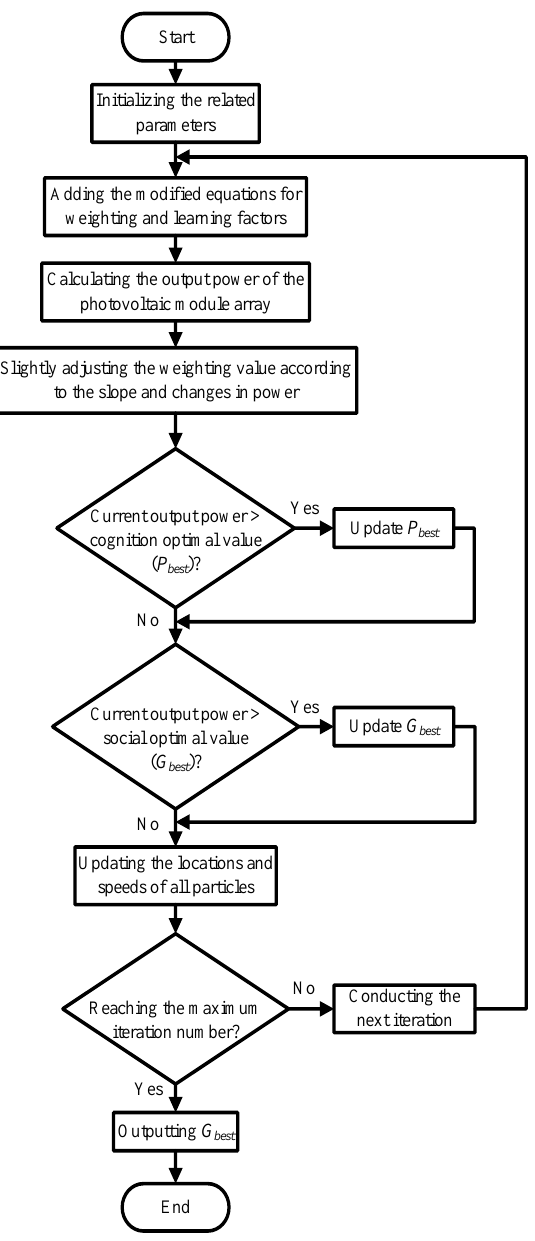
Figure 7. Flowchart of the modified PSO algorithm.